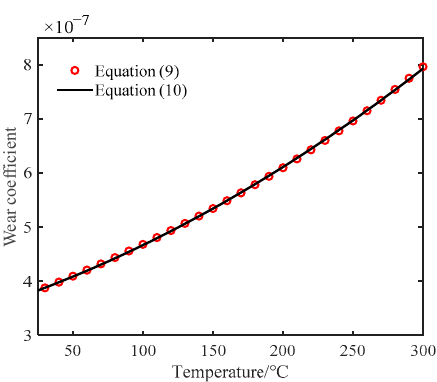
Figure 1. Fitting effect of energy wear coefficient.